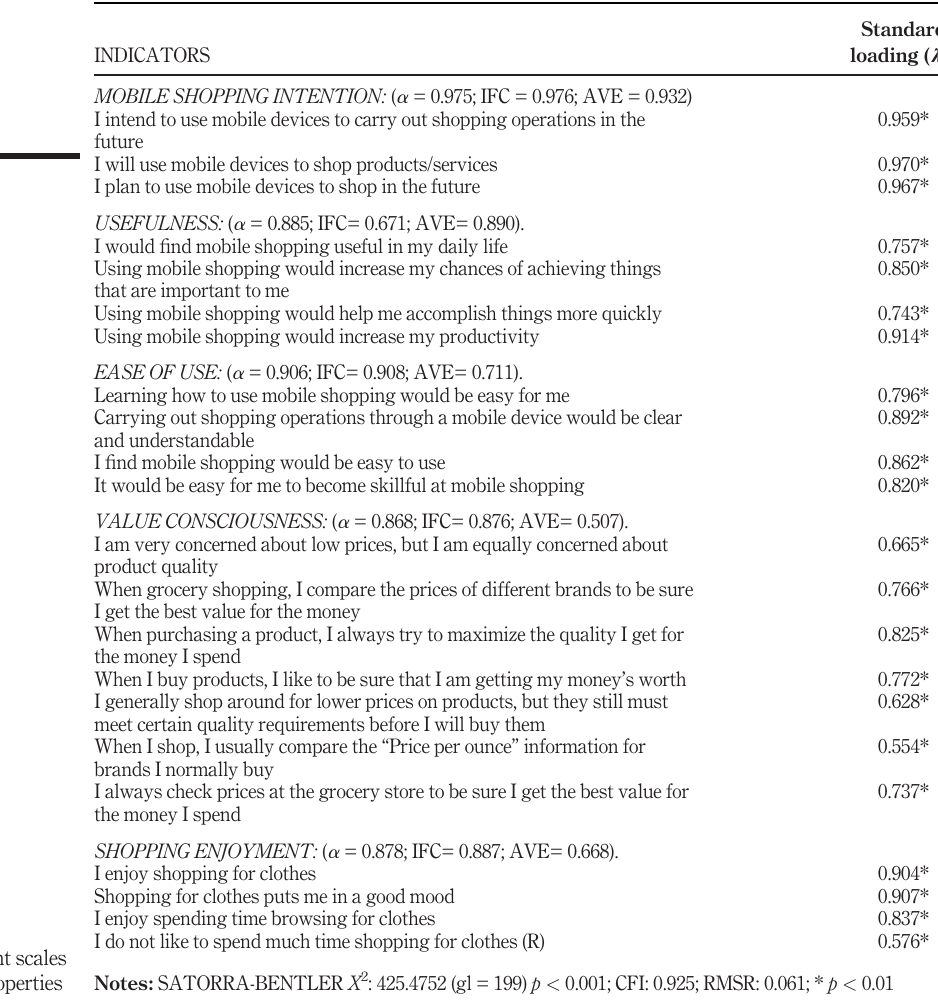
Table A1. Measurement scales used and